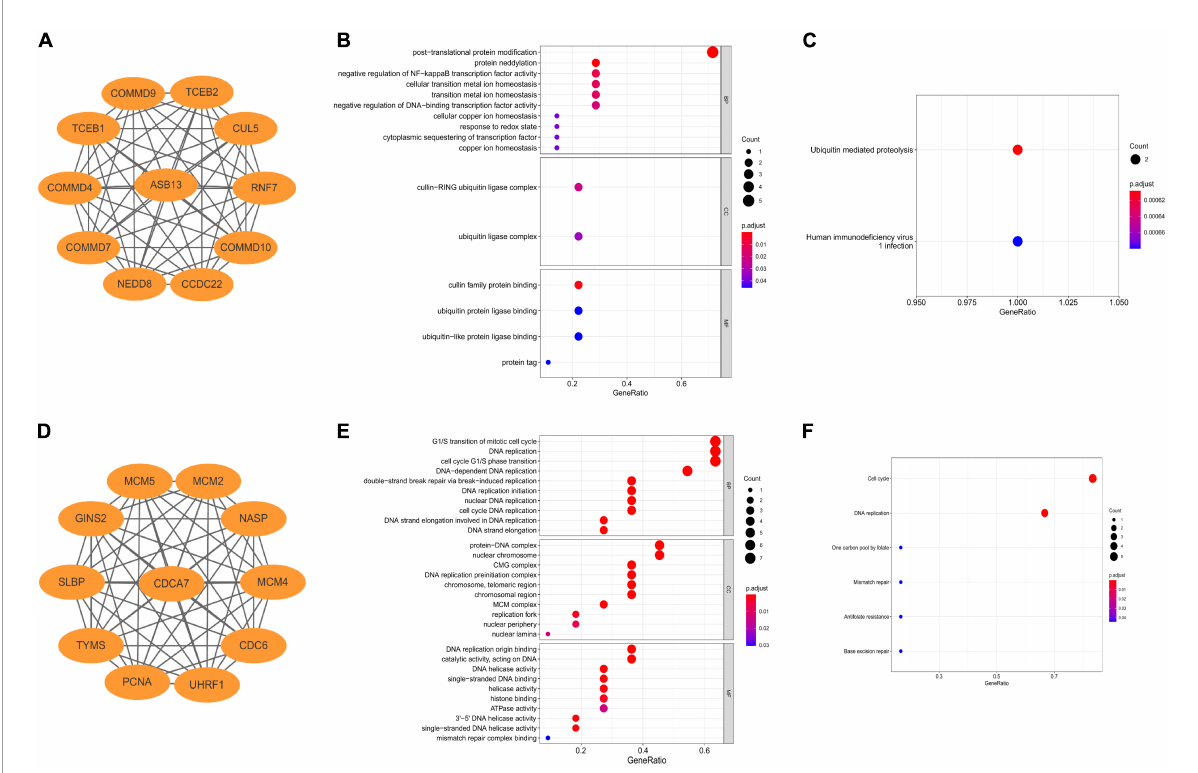
FIGURE4 Construction of co-expression regulatory network and enrichment analysis of hub programmed cell death (PCD)-related genes. (A) Co-expression regulatory network of ankyrin repeat and SOCS box containing 13 (ASB13). (B) Gene ontology (GO) analysis of the regulatory network of ASB13. (C) Kyoto Encyclopedia of Genes and Genomes (KEGG) analysis of the regulatory network of ASB13. (D) Co-expression regulatory network of cell division cycle associated 7 (CDCA7). (E) GO analysis of the regulatory network of CDCA7. (F) KEGG analysis of the regulatory network of